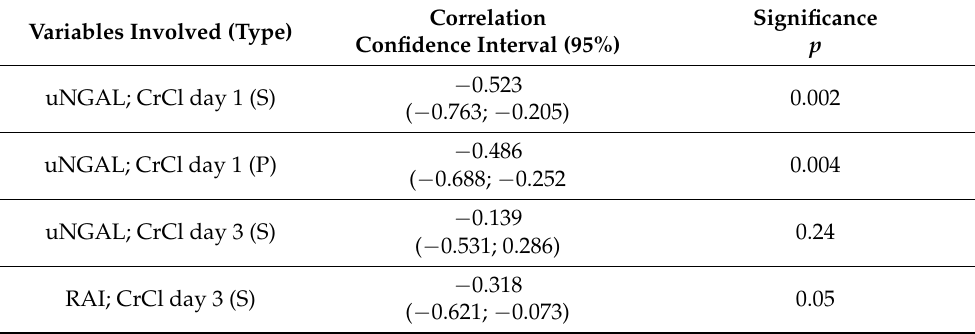
Table 1. The logistic regression coefficients for the dependent variable for day 1 CrCl < 90/mL/1.73 m 2